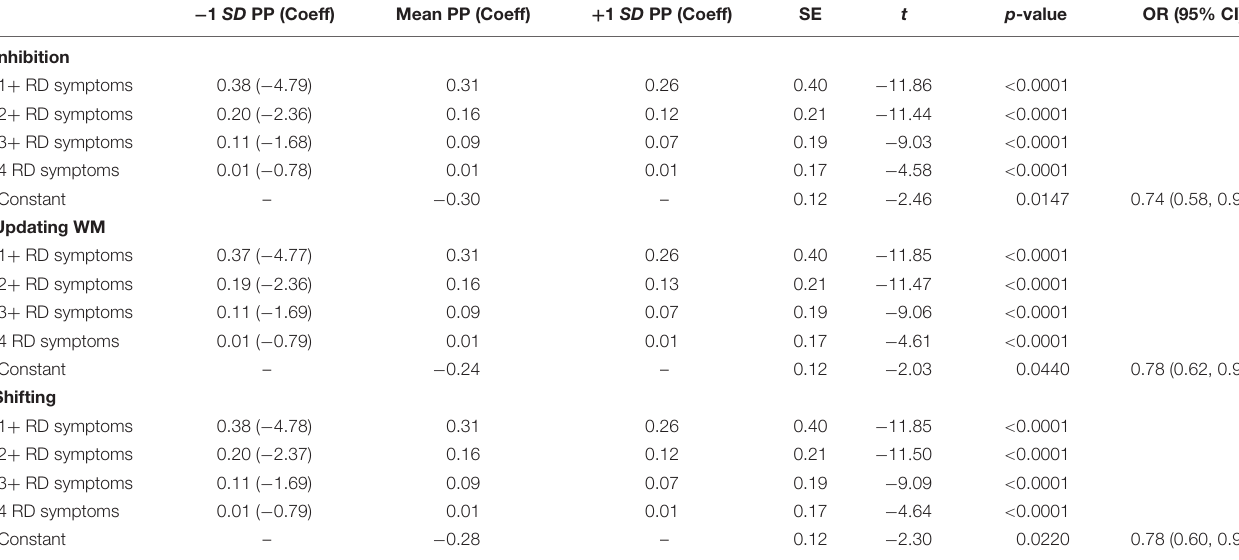
TABLE 5 | Hierarchical ordinal logistic regression